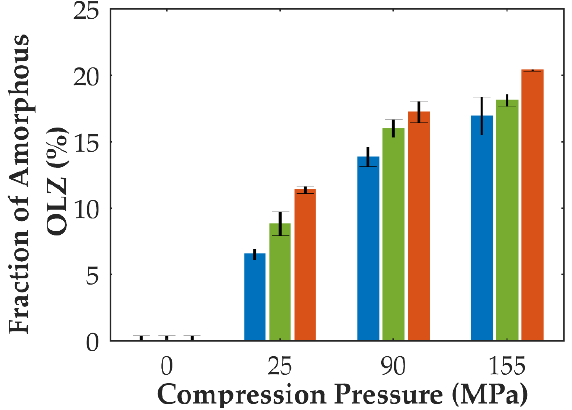
Figure 3. Predicted fraction of amorphous OLZ (formulation B) according to the compaction pressure (in x axis) and dwell time applied to compacts (blue: 0 min, green: 2 min, and orange: 5 min). Predictions were made according to da Costa et al. [19].